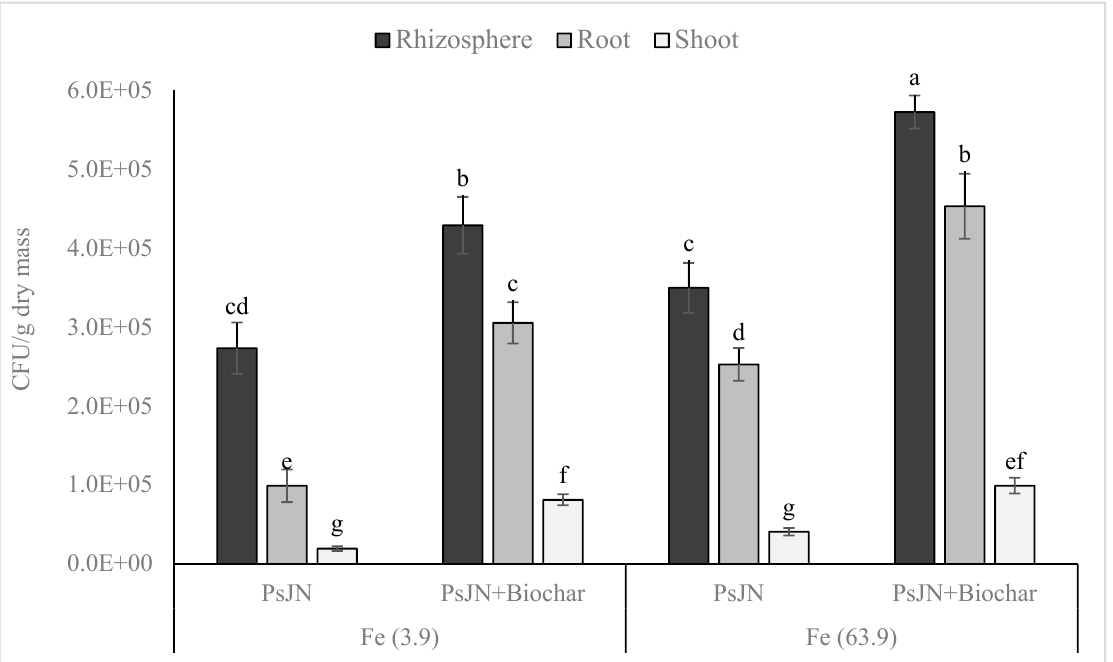
Figure 6. Persistence of selected endophytic strain in the shoot interior of Chenopodium quinoa under